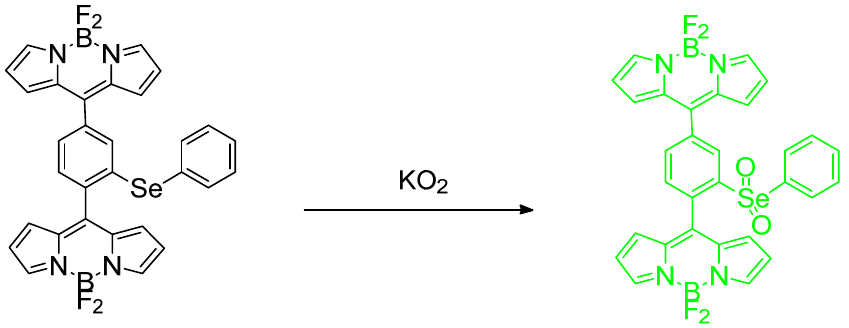
Figure 27. Chemical structure of the tandem fluorophore-substituted phenyl selenide moiety able to undergo oxidation at the Se center by Desmukh et al.